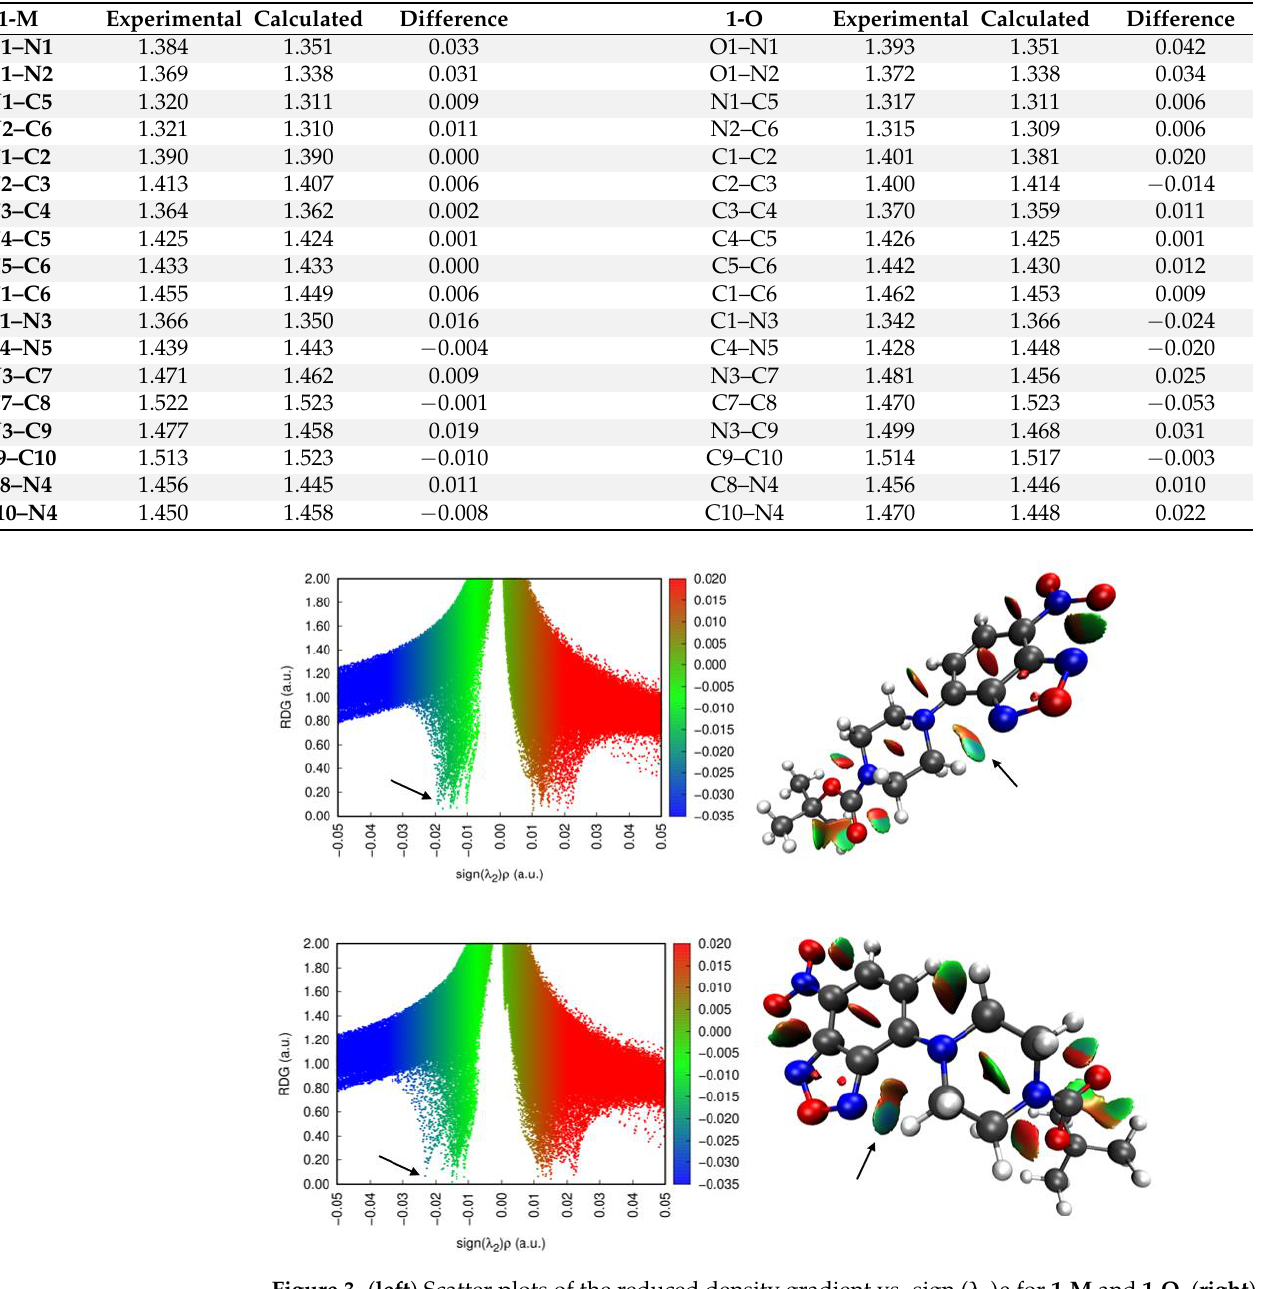
Figure 3. ( left ) Scatter plots of the reduced density gradient vs. sign ( λ 2 ) ρ for 1-M and 1-O . ( right ) The visualized RDG isosurfaces for both structures. Arrows are pointing to the corresponding points for the intramolecular H···N interaction.